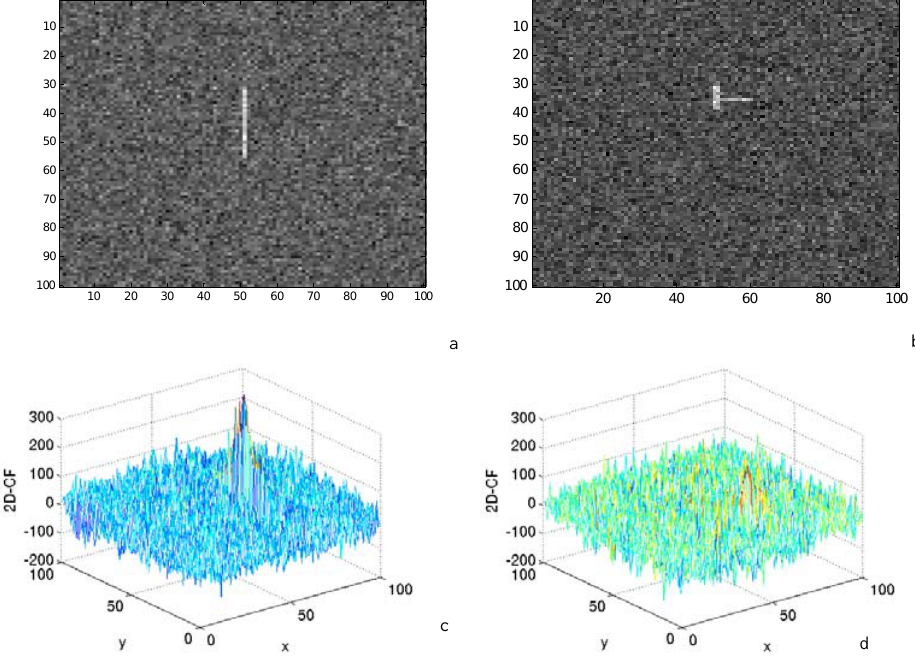
Figure 4. The effects of ships’ shape on convolution. a and b are gray images with ‘line’ and ‘T’ shape, respectively, c and d are 2D-CF values between co-polarization channels corresponding different ship